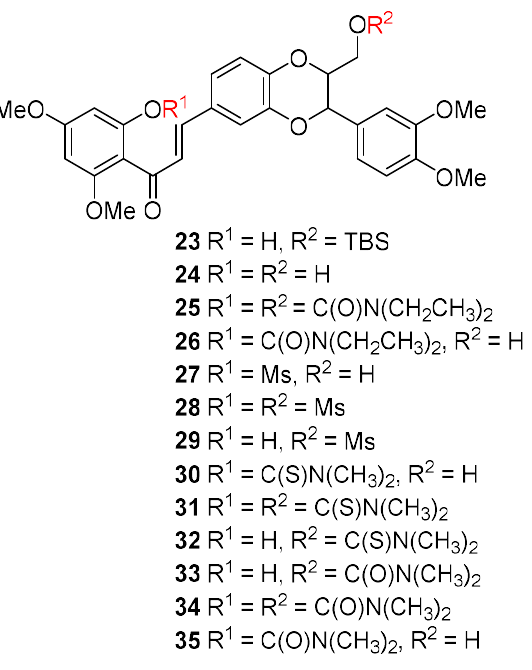
Figure 4. Chemical structures of chalcone-type flavonolignans.